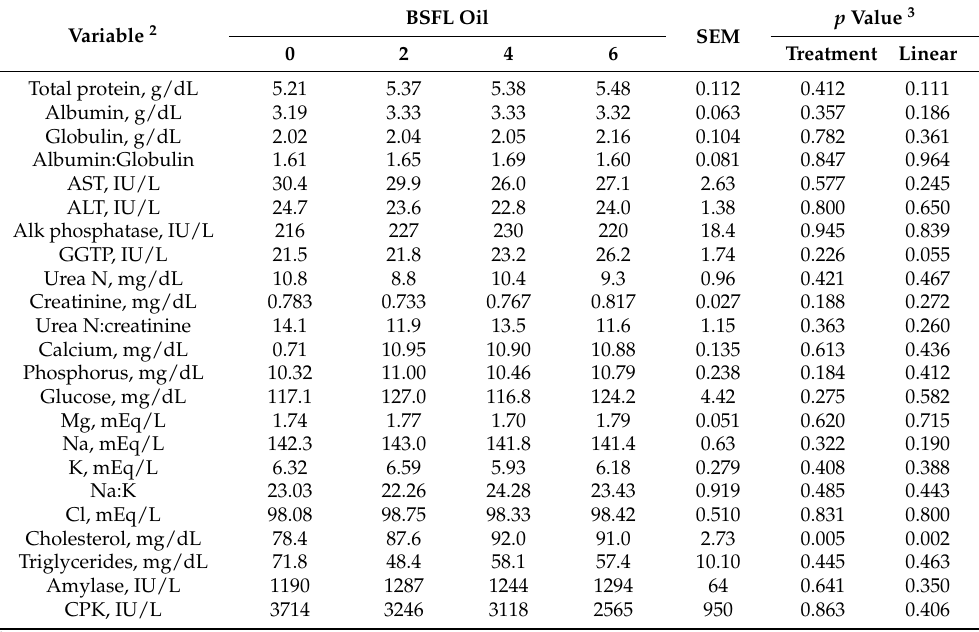
Table 5. Effects of black soldier fly larvae (BSFL) oil replacing equal amounts of corn oil on serum chemistry in nursery pigs 1 .